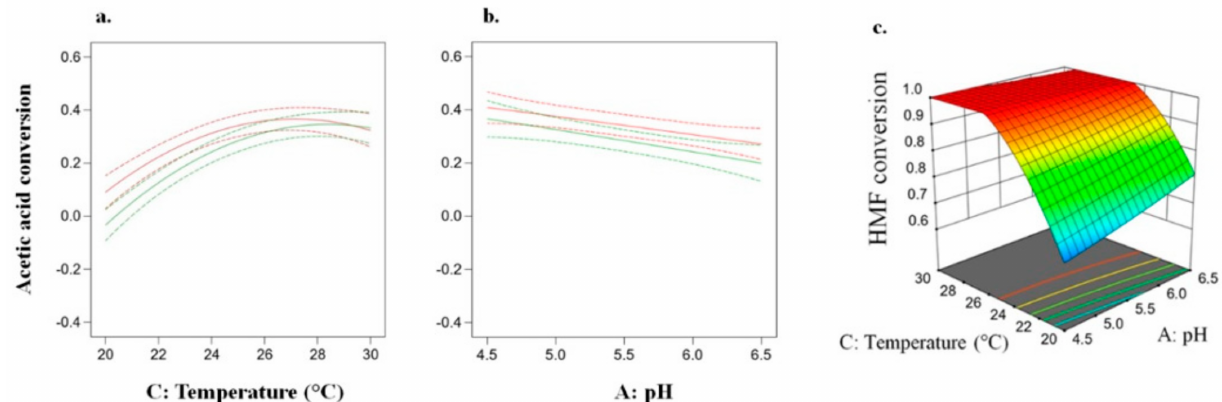
Figure 1. ( a ) Effect of the fermentation temperature and pretreatment condition on the acetic acid conversion (green = acid hydrolysis, red = hydrothermal), fermentation conditions: pH = 5.5, 100 rpm, t = 24 h; ( b ) Effect of the fermentation pH and pretreatment condition on the acetic acid conversion (green = acid hydrolysis, red = hydrothermal), fermentation conditions: pH = 5.5, 100 rpm, t = 24 h; ( c ) Effect of the fermentation pH (A) and temperature (C) on the HMF conversion.